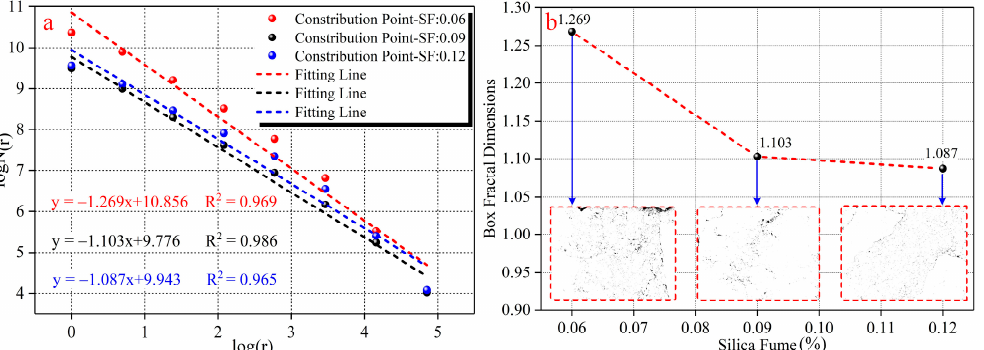
Figure 6. The influence of SF on fractal dimensions. ( a ) is the fitting calculation results of fractal dimension. ( b ) is the influence of SF on fractal dimension.